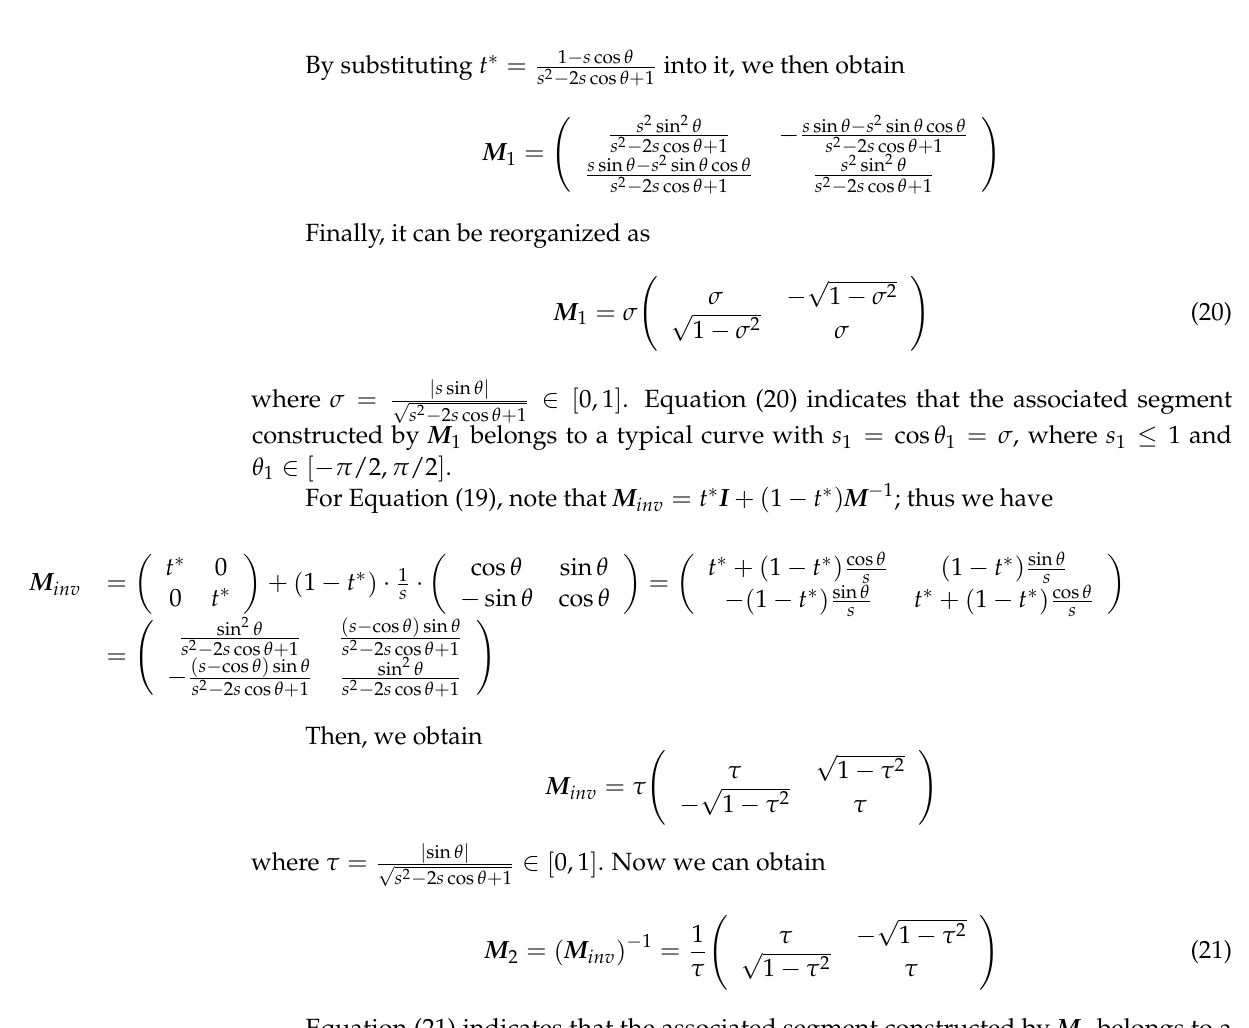
(Figure 11), the minimal